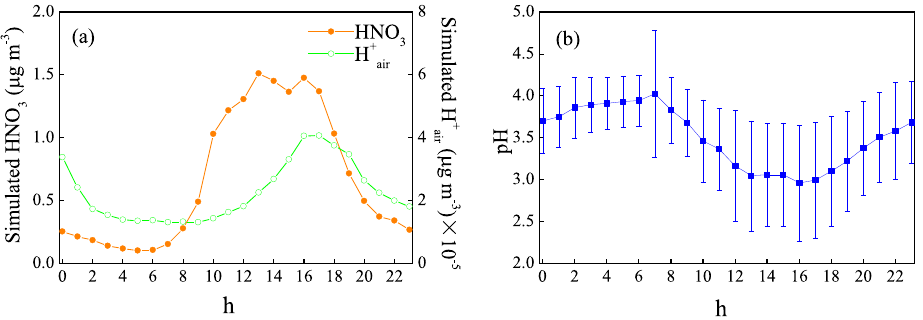
Figure 6. Simulated diurnal variation in HNO 3 and H + 2013.